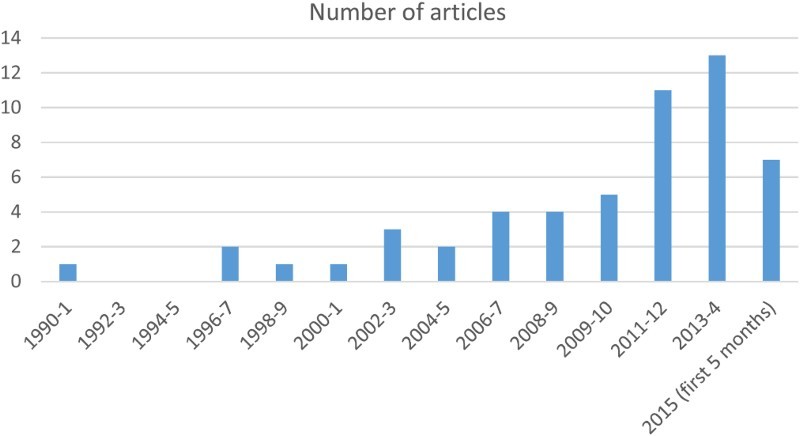
Articles by year.